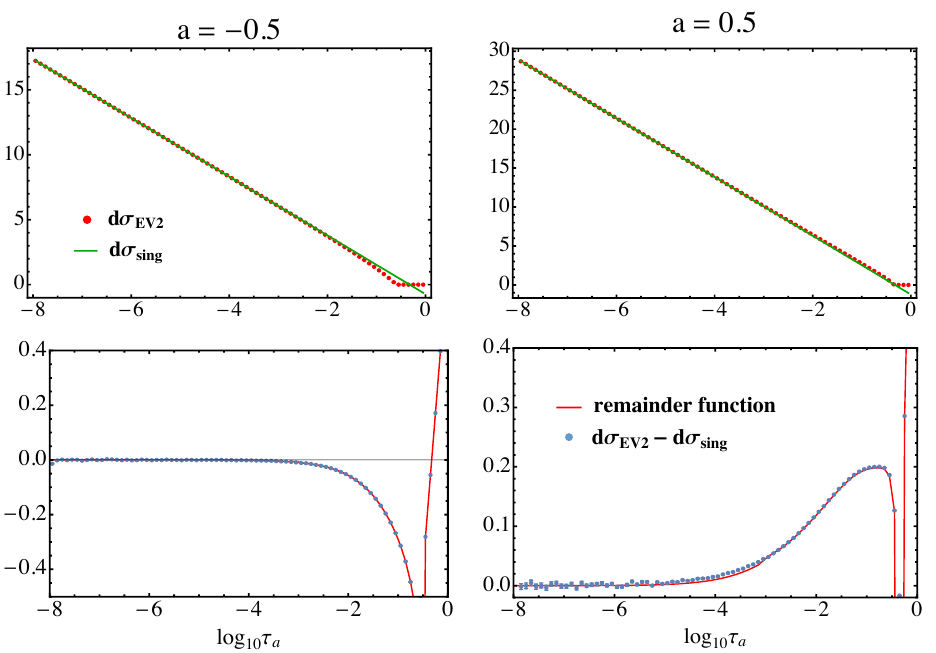
Figure 3 . Top : comparison of the EVENT2 prediction for two angularity distributions at with the analytically-known singular terms that follow from eq. (3.5). Bottom : comparison of their di(cid:11)erence with the remainder function r 1 ( (cid:28) a ) from